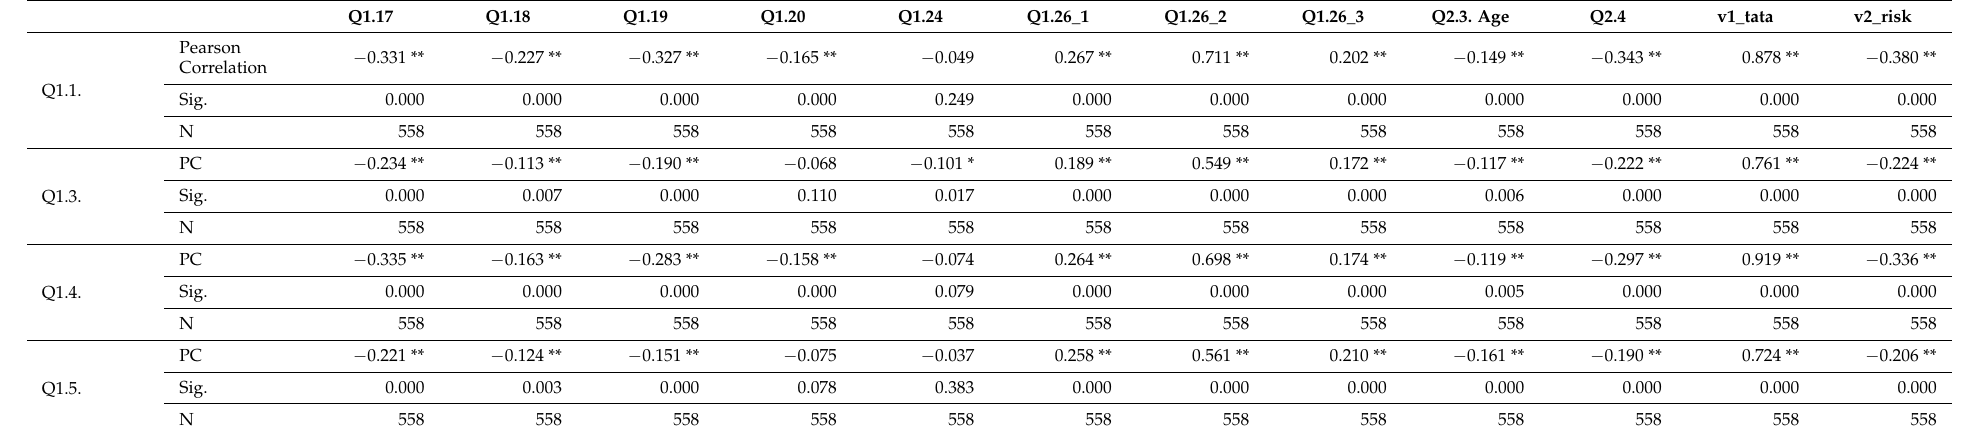
Table A2. Q1.1 In general, how do you evaluate the relationship you have with your father? Q1.3 Thinking about the last year, how many times a week did you do something with your father (talked, watched movies, participated in sports activities, gaming, shopping, etc.)? Q1.4 How close are you to your father? Q1.5 How many hours do you spend in conversations with your father every week? Q1.6 How many times do you talk to your father every week? Q1.7 When your father is away from home, how much do you miss him? Q1.8 How long do you think you spent with your father in the last year? Q1.9 How much did you enjoy